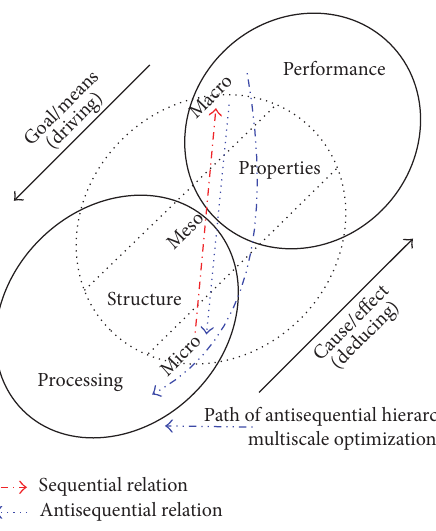
Figure 2: Antisequential hierarchical multiscale relationship.